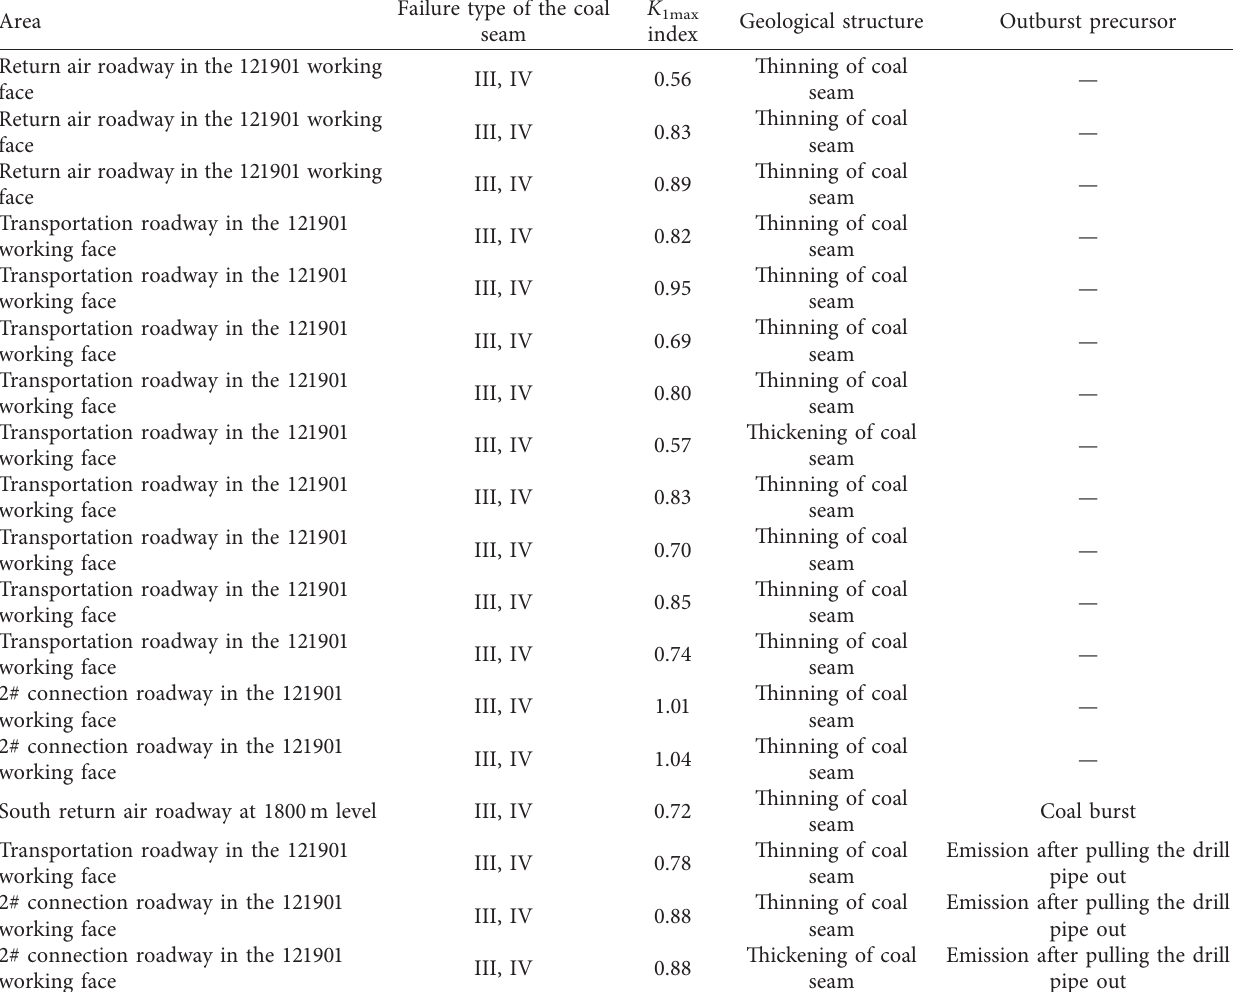
Table 5: Gas desorption index K 1 of drilling cuttings based on geological structure and precursor areas of